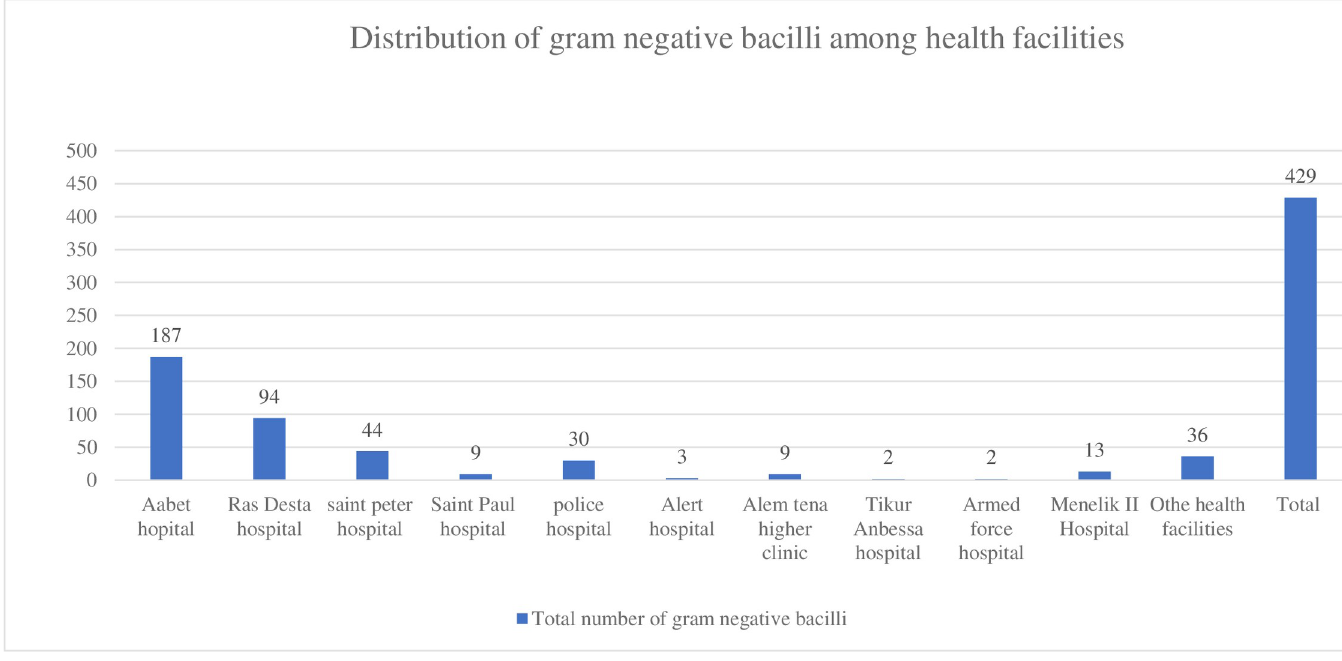
Fig 1. Distribution of gram-negative bacilli among health